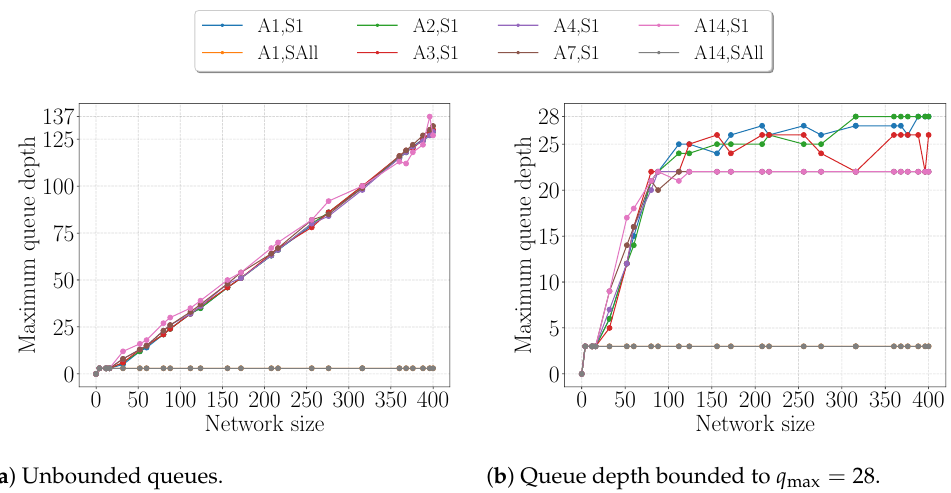
Figure 30. Maximum queue depth observed during slotframe execution. UWB-TSCH is configured with 8 channels. Each scenario is named A m ,S n where m is the aggregation level, n agg , and m the number of